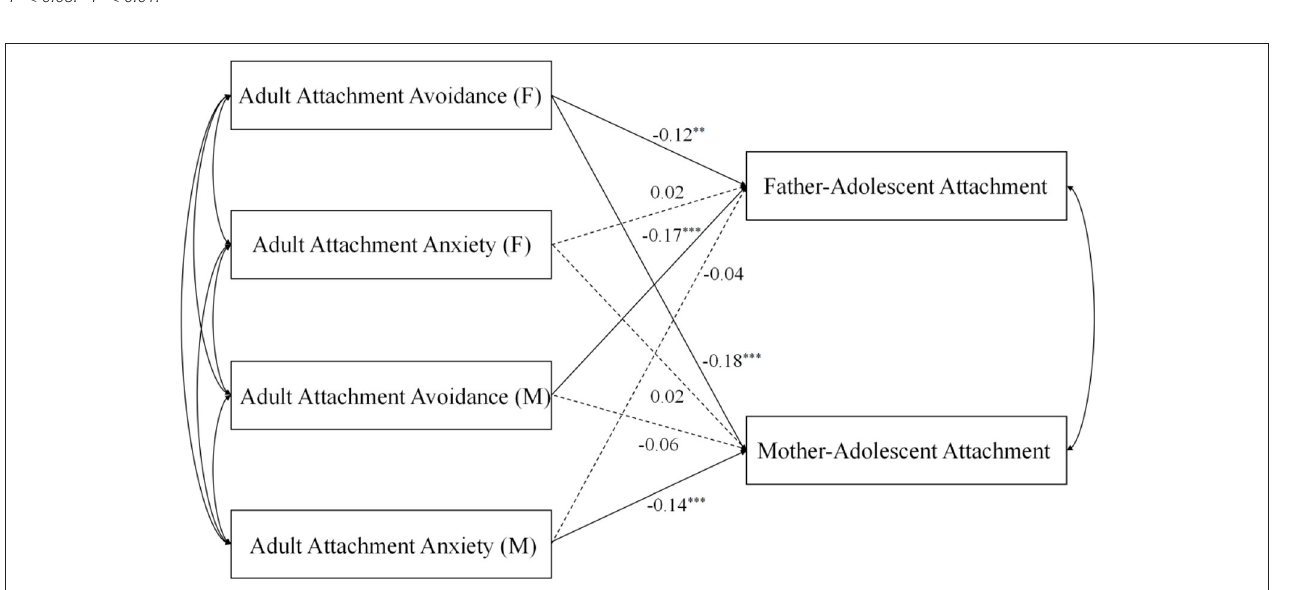
control and excessive intimacy, which is also not conducive to the development of healthy mother–adolescent